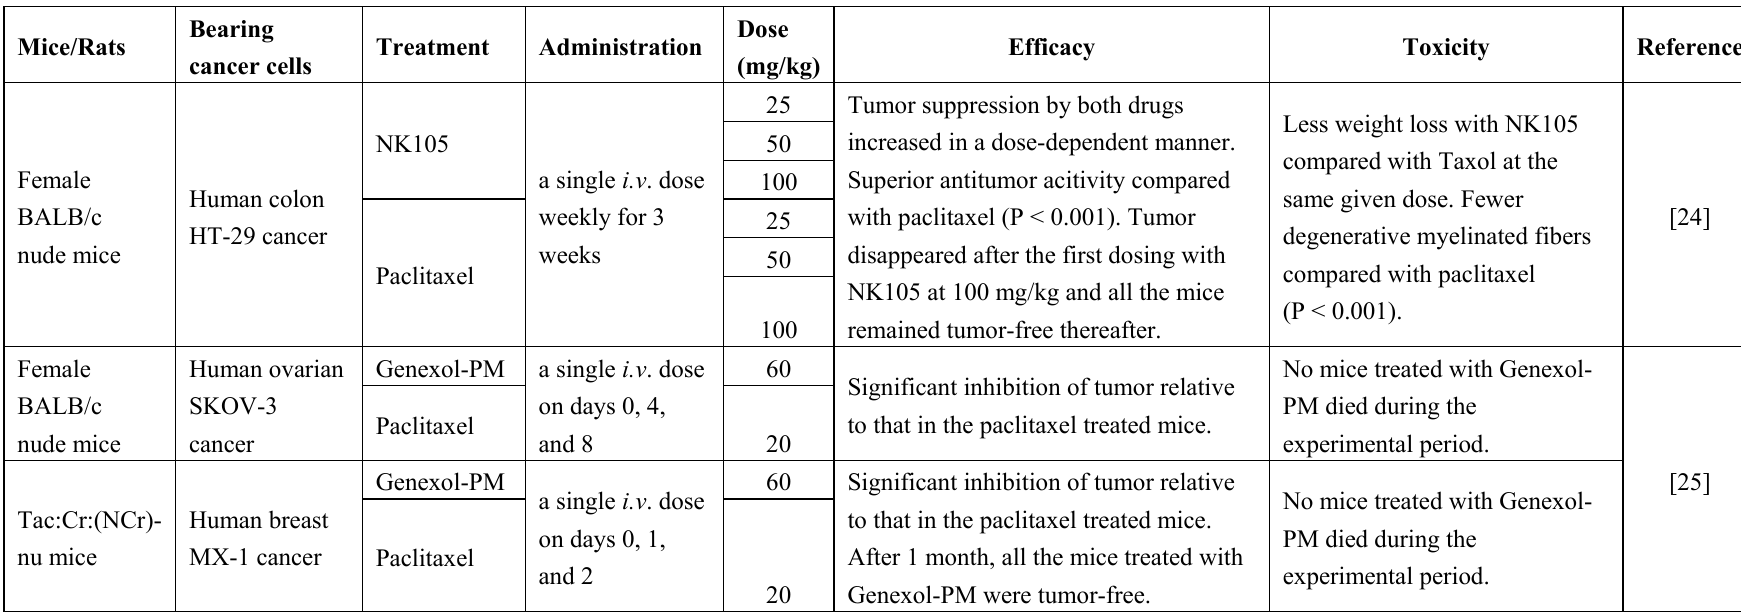
Table 4. A summary of in vivo efficacy of polymeric paclitaxel micelles and Taxol in mouse models.